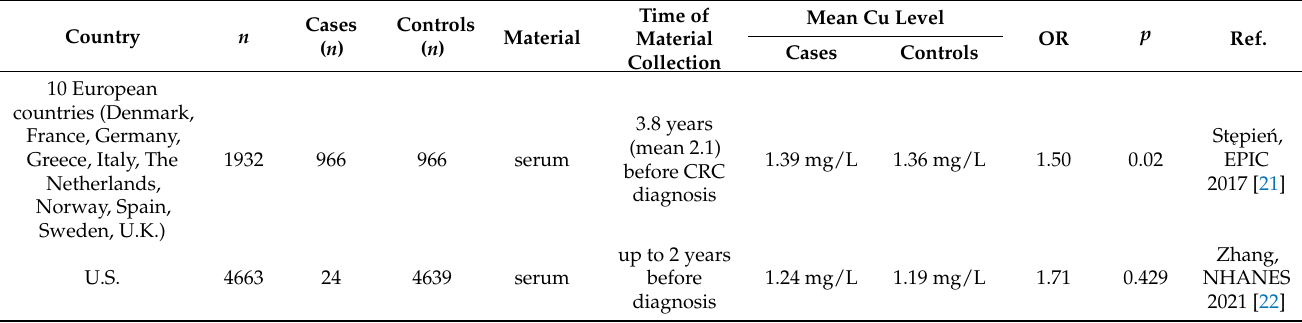
Table 14. Prospective studies on association between copper level and risk of colorectal cancer.